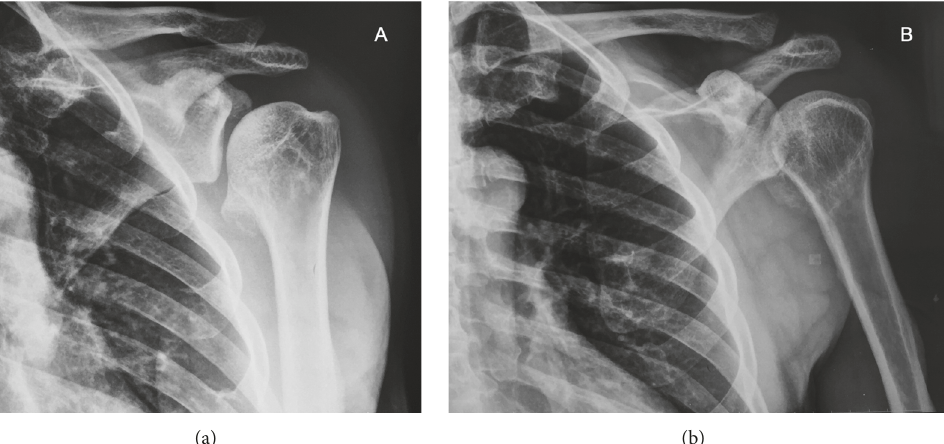
Figure 2: Radiographs of the left shoulder demonstrated abnormal morphology of the left humerus head, characterized by a large anteromedial exostosis arising from the epiphysis of this bone. The initial diagnosis was DEH. In addition, slight proximal migration of the distal part of the left clavicle was noted (Rockwood and Neer grade 2 AC dislocation), with no signs of AC degenerative disease. (a) True AP view and (b) AP view with maximal internal